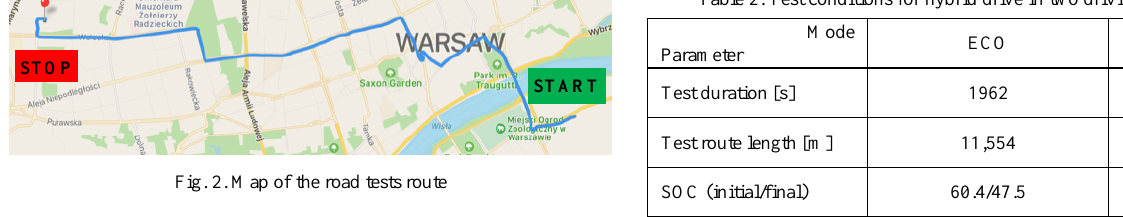
Fig. 3. The route drive characteristics with marked time densities of accel- eration, constant speed, braking and stopping of the vehicle in the repeated drives on the same route: a) ECO mode, b) ECO + EV mode Table 2. Test conditions for hybrid drive in two driving